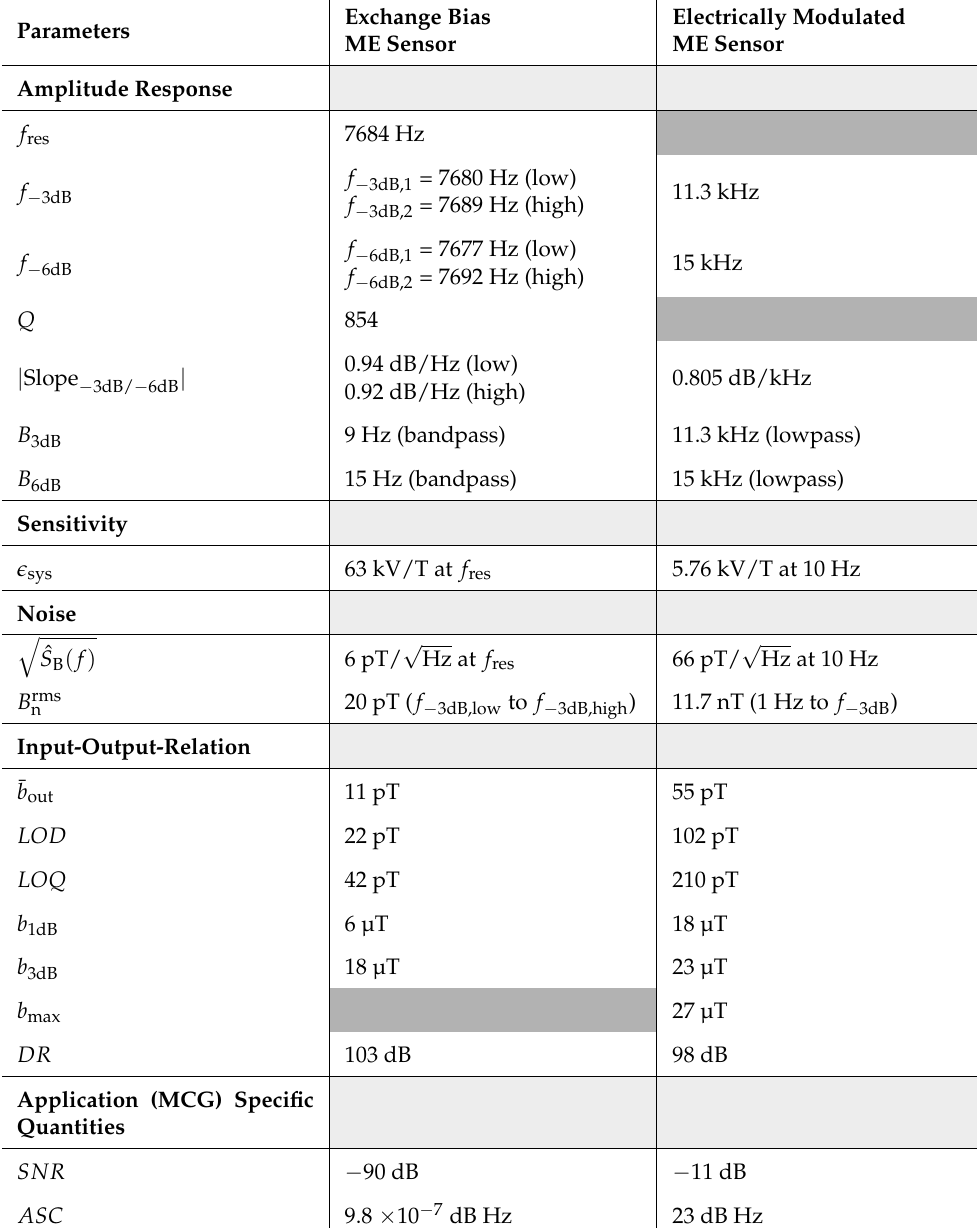
Table 2. Comparison of magnetic field sensor systems evaluated within this